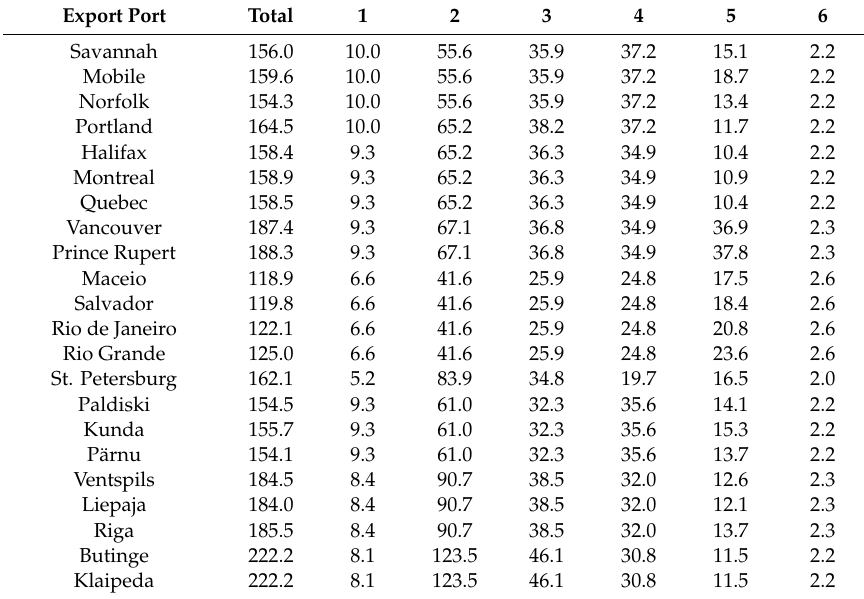
Table A9. Overview of supply chain costs of pellets produced from roundwood, transported over 500 km to export ports and including 50 km feedstock transport, in € / t pellets. Components included in the table: 1. Feedstock transport; 2. Feedstock; 3. Pelletizing; 4. Pellet transport; 5. Shipping; 6. Port